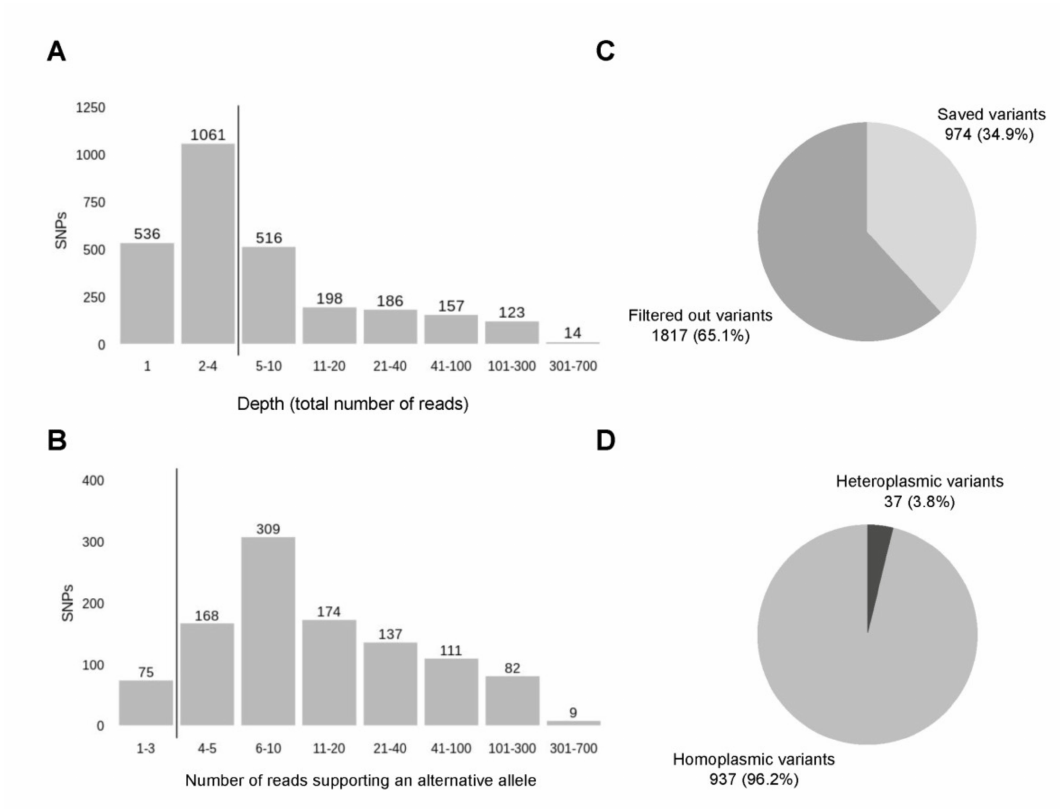
Figure 7. Filtration of the variants. ( A ) The first step of filtration or filtering out the variants with the lowest depths (less than 5), the vertical line sets the threshold. ( B ) The second step of filtration or filtering out the variant with the low number of reads carrying an alternative allele, the vertical line sets the threshold in 4 reads. ( C ) The distribution of variants after two steps of filtration. ( D ) The distribution of filtered variants by the number of reads supporting a reference allele—homoplasmic (all reads carry an alternative allele) and heteroplasmic (there are both reads with alternative and reference